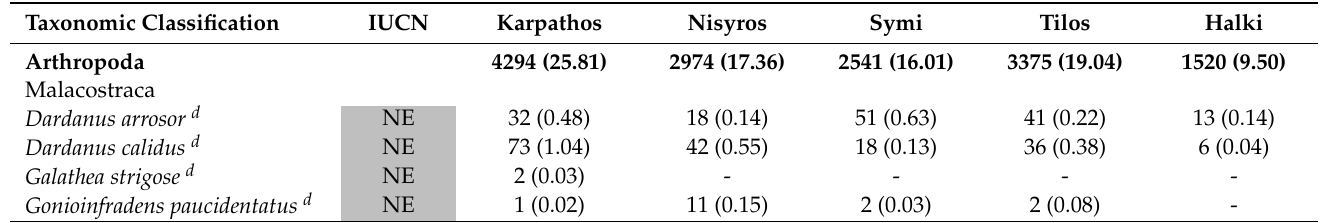
Table 2. Species list of incidental catch ( i ) and discards ( d ) in the number of individuals and total biomass (kg; in brackets) for each of the sampling locations (i.e., Karpathos, Nisyros, Symi, Tilos and Halki) during an annual cycle from 2014 to